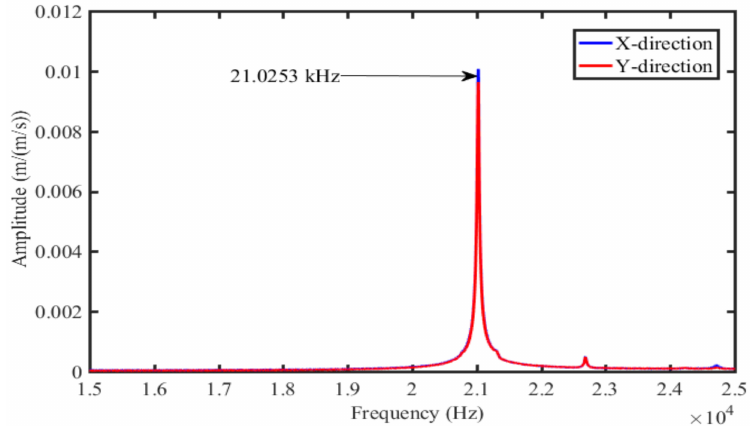
Figure 2. The measured frequency–amplitude curves of the ring